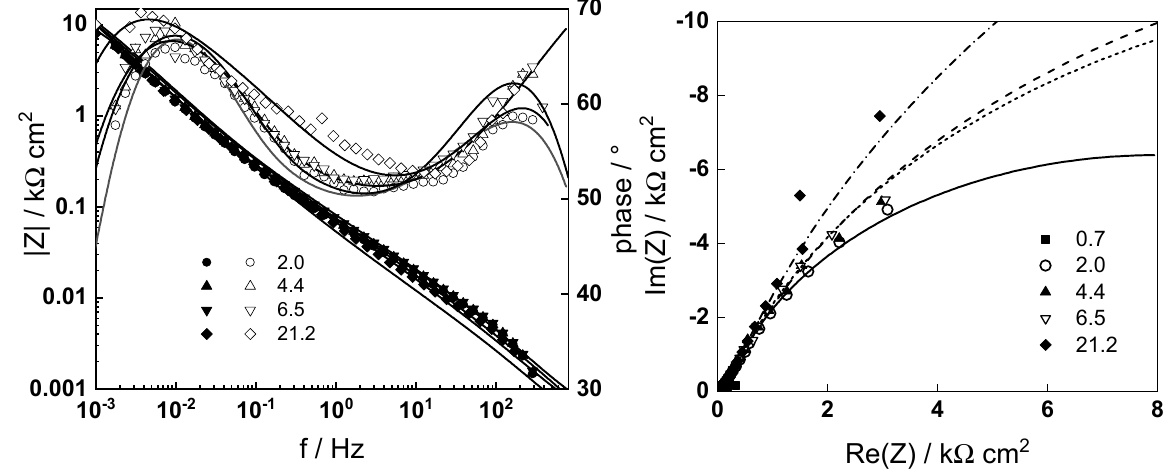
Figure 6. Electrochemical impedance spectra of AISI 316L at 180 ° С in AMETA with 0.1 g dm − 3 mag- netite particles. ( left )—impedance magnitude (full symbols) and phase shift (open symbols) vs. fre- quency, ( right )—complex plane representation. Points—experimental data, solid lines—best-fit cal- culation with respect to the MCM equations discussed in the text. The legend is oxidation time (h).